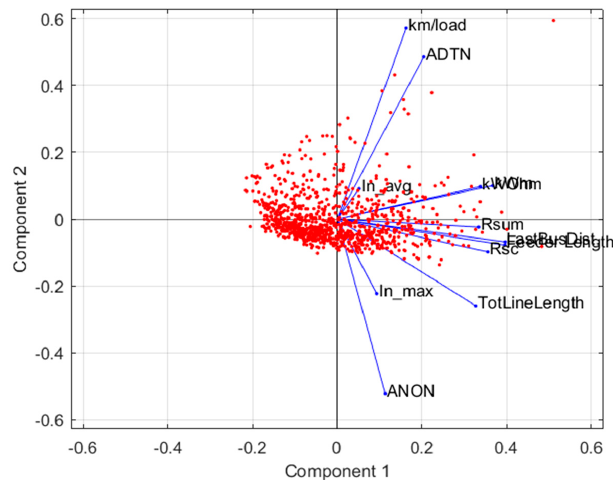
Figure 4. Projection of the parameters on the first two components obtained from a principal component analysis, including a random subset (1000) of the feeder data set (red points).